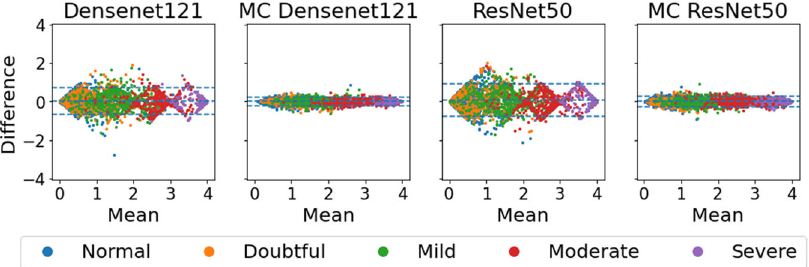
Fig. 5 Architecture comparison on multiclass model for knee osteoarthritis grading. The two fi rst columns are the model trained with Densenet121, while the two last ones were trained with ResNet50. The fi rst and third graphs represent the regular model and the second and fourth ones display their MC